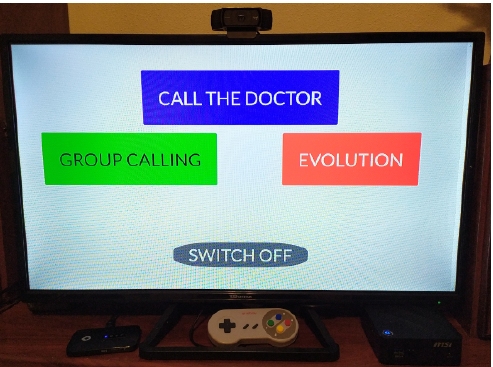
Figure 4. Installation of the equipment at the patient’s house with its main interface on the